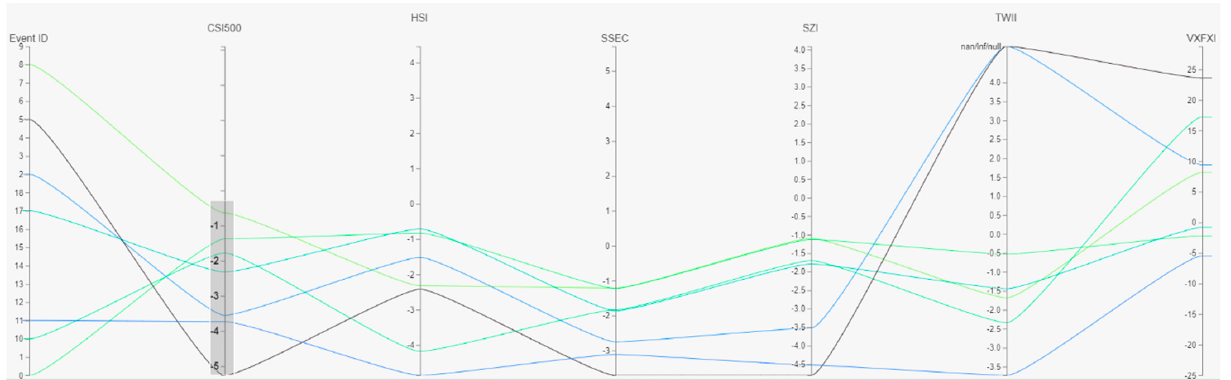
Figure 11. Negative events in most cases (TWII does not have values on 23 January 2021 and 28 February 2021; hence, there are two nulls in the figure; darker colours indicate negative events that affect the CSI500 index more). Table 5. Stock market index and its related major evens.